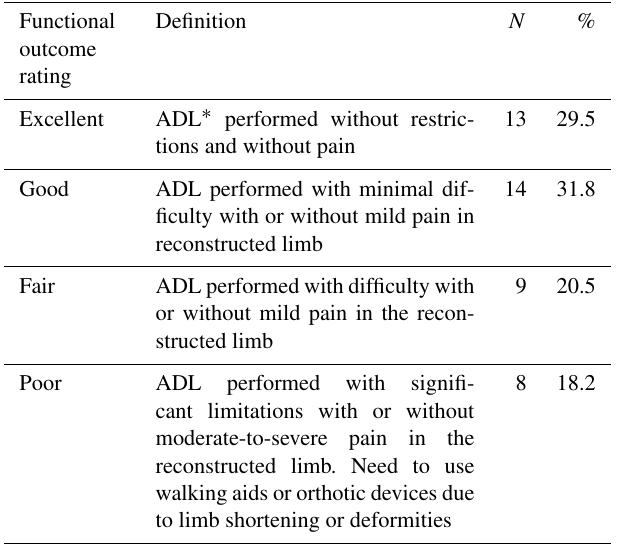
Figure 4. Radiographs taken 5 years apart following an osseous graft in the femur of a 5-year-old boy. Remodeling has made the grafted segment indistinguishable from the host bone. Table 6. Functional outcomes, as rated by the patients, at the last follow-up